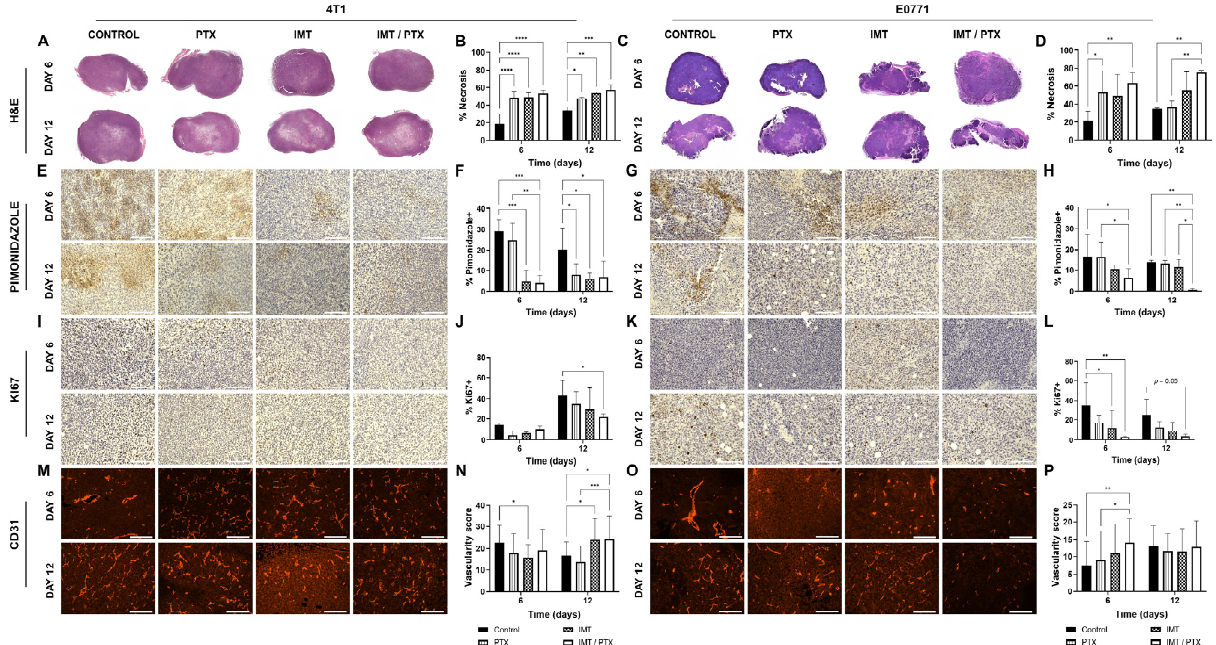
Figure 3. Histochemical imaging and quantitative analyses performed on TNBC tumors validate findings from analysis of FMISO-PET imaging data. ( A – D ) 4T1 and E0771 tumors were harvested on days 6 and 12, sliced, and stained with H&E and percentage of viable tumor tissue was quantified. Tumors were also stained and quantified for ( E – H ) pimonidazole, a marker for hypoxia, ( I – L ) Ki67, a marker for proliferation, and ( M – P ) CD31, a marker for vasculature (20× magnification; scale: 125 µm). Mean ± SD (* indicates p < 0.05; ** indicates p < 0.01; *** indicates p < 0.001; **** indicates p < 0.0001; multiple t -tests).